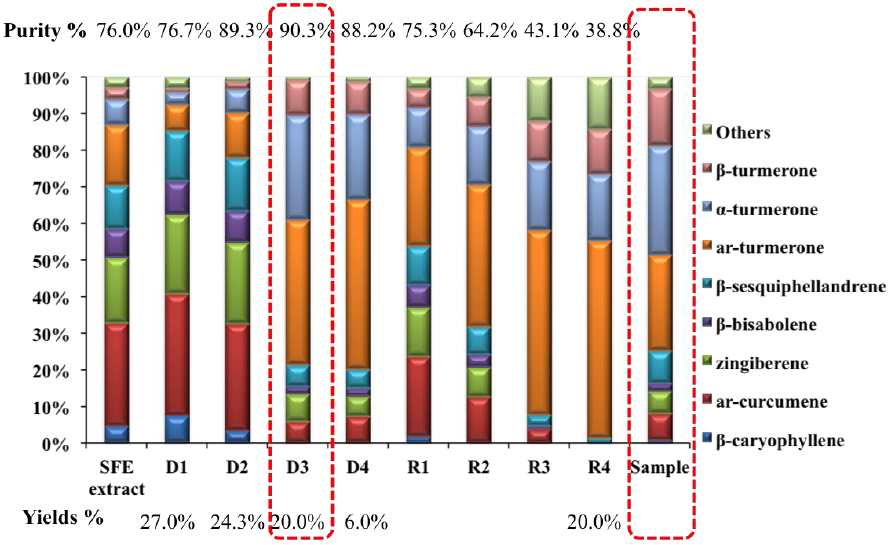
Figure 3. Comparison of contents, purity, and yields of distillates by molecular distillation.